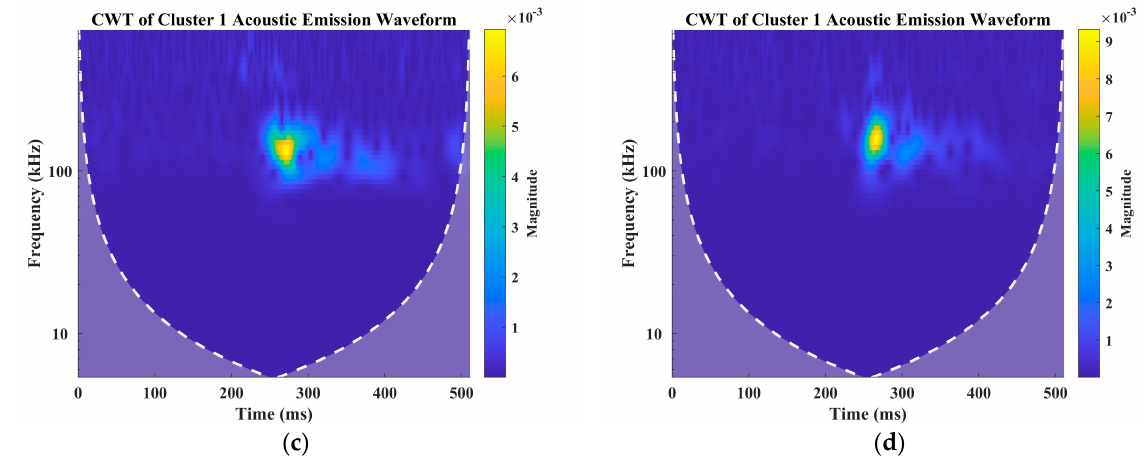
Figure A2. CWT spectrograms of four randomly selected AE signals ( a ) Signal 1; ( b ) Signal 2; ( c ) Signal 3; ( d ) Signal 4 from Cluster 1.